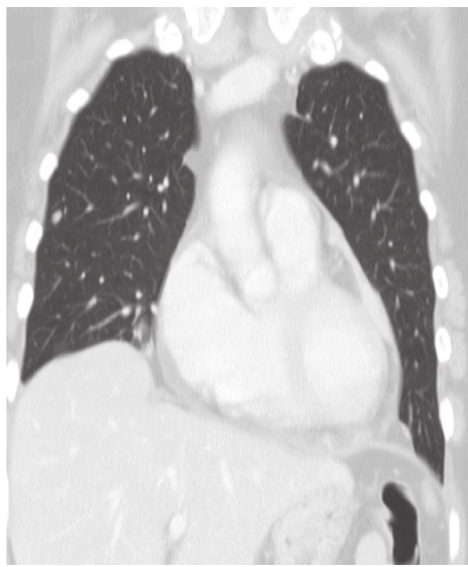
Figure 1: Thoracic computed tomography showing the presence of pericardial